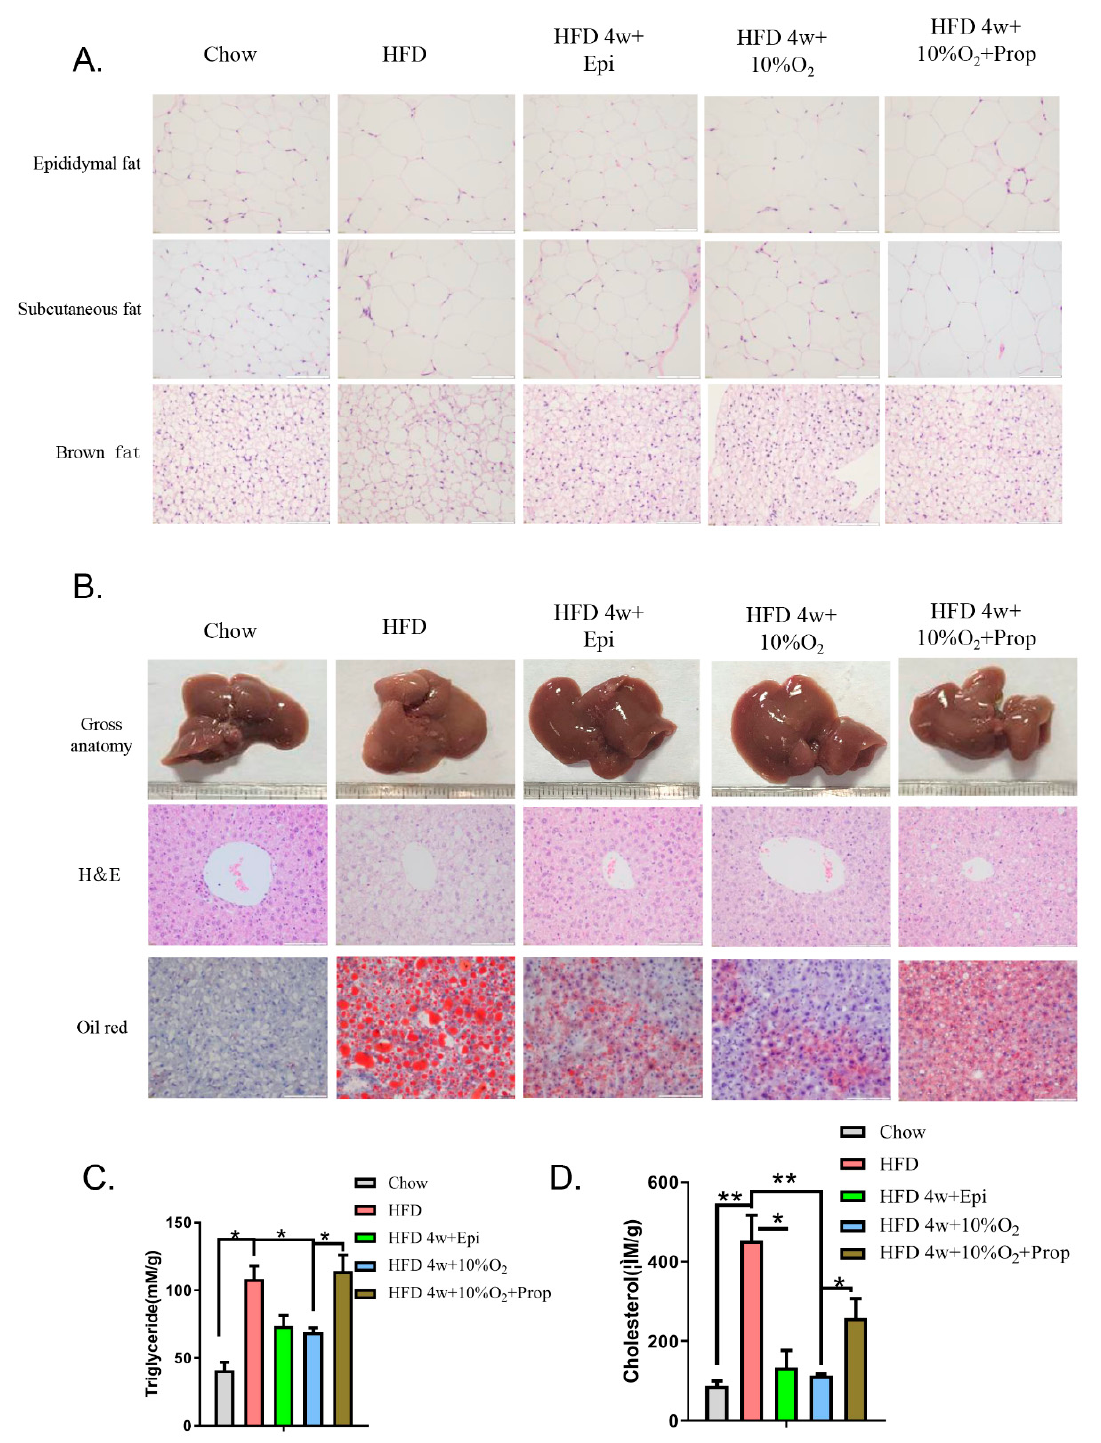
Figure 5. Epinephrine mediates the effect of hypoxia on fat deposits in liver and adipose tissues. Mice were treated as in Figure 4. ( A ) Epididymal fat, subcutaneous fat, and brown fat were isolated and stained with H&E. Representative images are presented (40 × ). ( B ) Representative images of gross liver and H&E and oil red O-stained liver tissues (40 × ) are presented. ( C , D ) Liver extracts were prepared, and triglyceride ( C ) and general cholesterol ( D ) measured. Statistical analysis was performed using Student’s t -test (mean ± SEM, n = 3). * p < 0.05, ** p < 0.01.